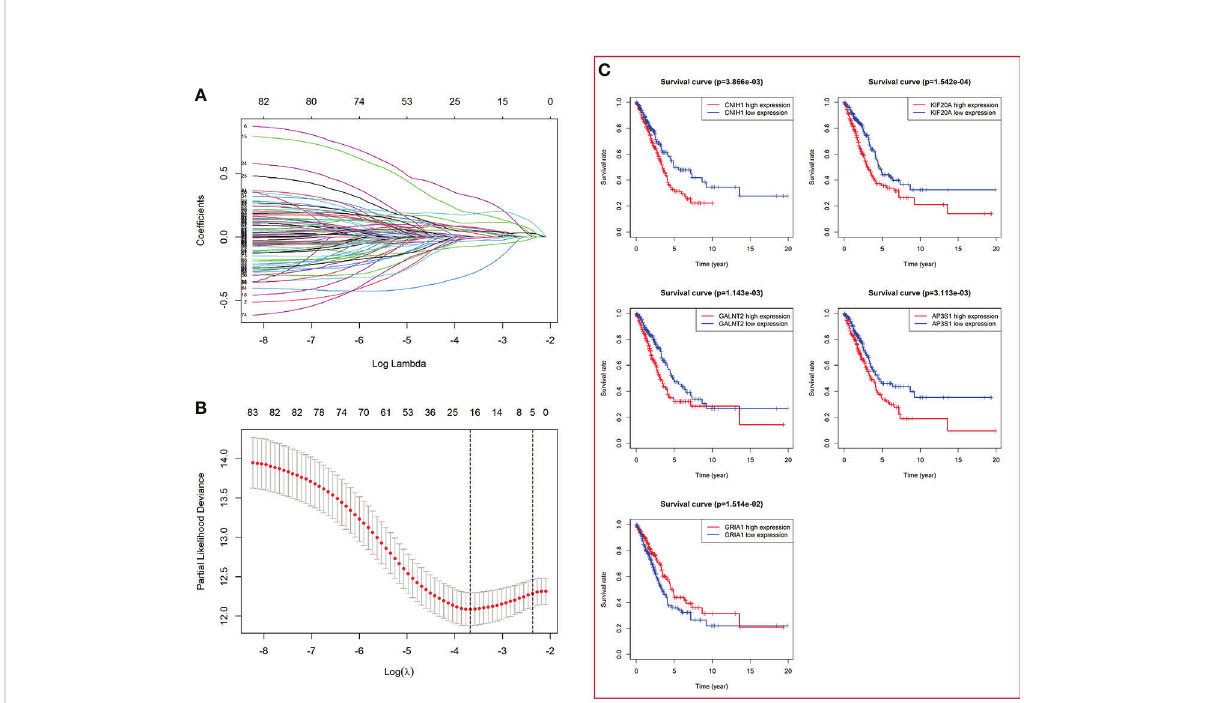
FIGURE 2 Construction of a vesicle-mediated transport-related genes prognostic model. (A) LASSO coef fi cient spectrum of 85 vesicle-mediated transport-related genes. Each curve represents a gene. (B) Cross-validation of adjustment parameter selection in a proportional hazards model. (C) The OS from the TCGA-LUAD dataset in relation to genes of constructed prognostic model including CNIH1 , KIF20A , GALNT2 , GRIA1 , and AP3S1